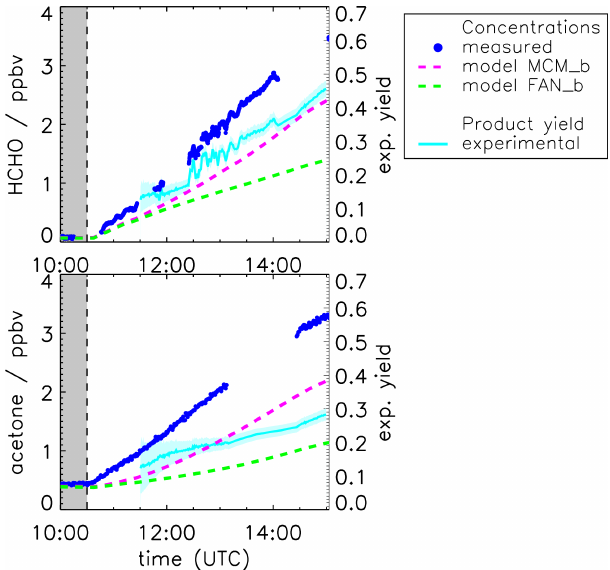
Figure 5. Measured and modeled formaldehyde and acetone mix- ing ratios for the experiment without OH scavenger. All model runs were done with measured photolysis frequencies for pinonaldehyde and with HO 2 constrained to measurements (see Fig. 7). Model runs were done using the MCM and the MCM with modifications de- scribed in Fantechi et al. (2002). In addition, yields calculated from measured time series are shown (see text for details) with the 1 σ error derived from measurements and errors of the applied correc- tion. Colored areas give the uncertainty of this calculation. The ad- ditional error caused by the uncertainty of the chamber source is not included